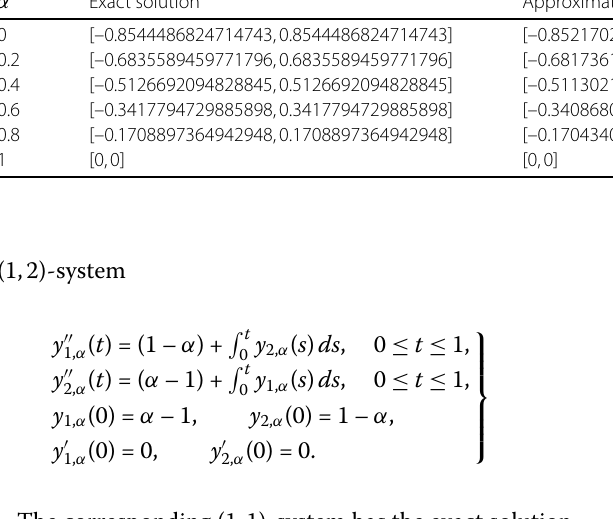
Table 2 Numerical results for (1,2)-system at t = 0.5 and various α α Exact solution Approximate